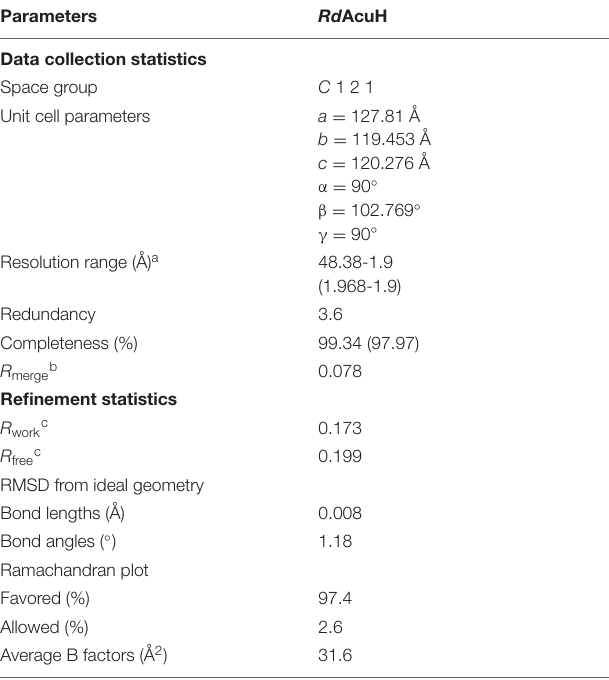
TABLE 1 | Data collection and refinement statistics.